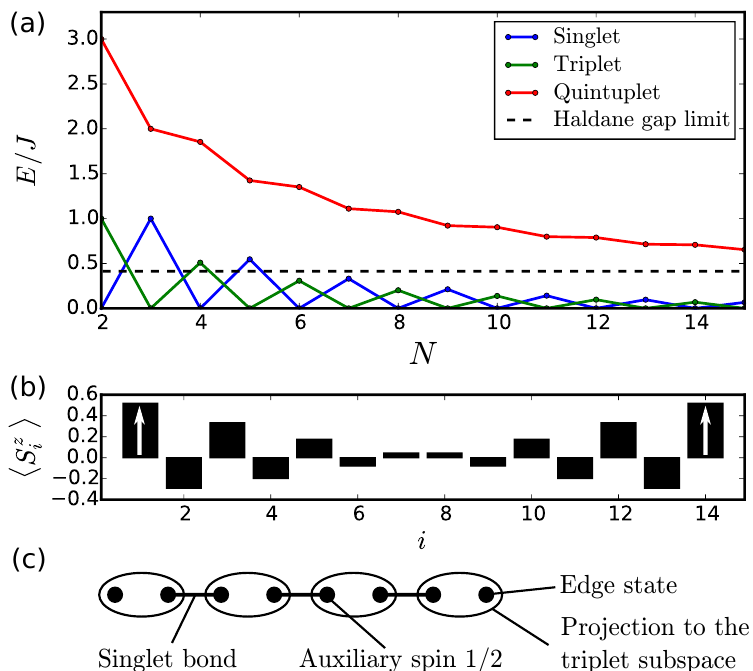
Figure 1. The Haldane phase. ( a ) the low-energy spectrum of spin-1 chains as a function of chain length N , obtained using exact diagonalization; ( b ) average spin density per site in S z = 1 triplet ground state of a N = 14 chain. The white arrows symbolize the effective spins-1/2, indicated by spin density close to 1/2 at the edges. ( c ) The Affleck-Kenedy-Lieb-Tasaki (AKLT) construction of the ground